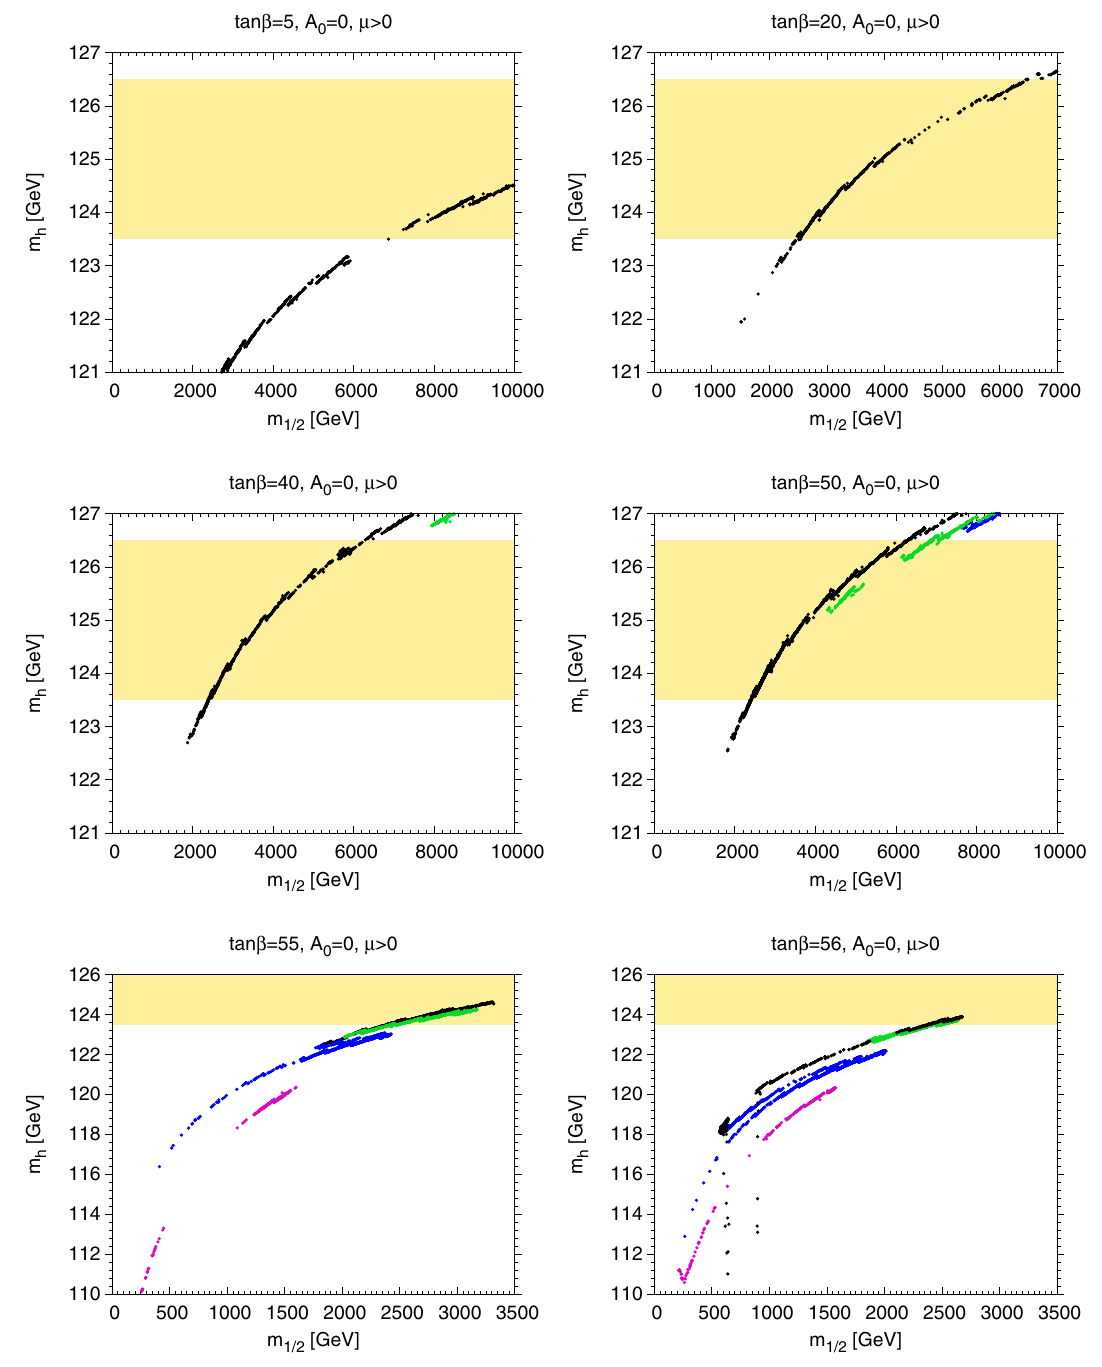
Fig. 8 The yellow shading indicates the impacts of the LHC measurement of m h , as calculated using FeynHiggs 2.18.1 and allowing an uncertainty of 1.5 GeV, on the dark matter strips for tan β = 5 , 20 , 40 , 50 , 55 and 56 with A 0 = 0 and μ > 0 (cid:9) π = 46 ± 11 MeV and σ = 35 ± 16 MeV, respectively. N s The corresponding typical uncertainties in the elastic cross sections are of order